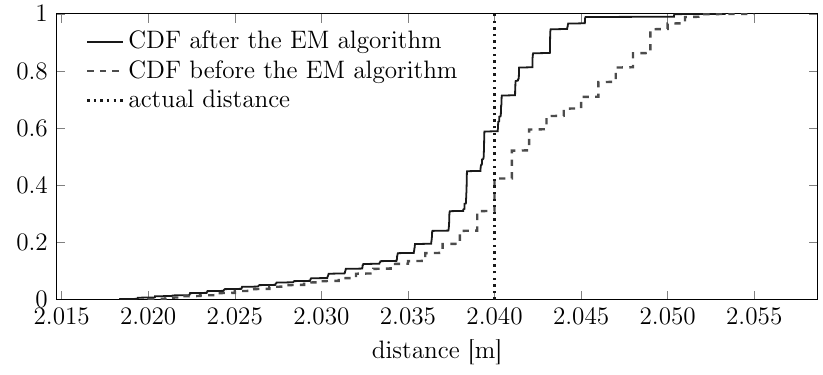
Figure 12. Effects of compensating some raw data with the biases corresponding to the lasing mode of each